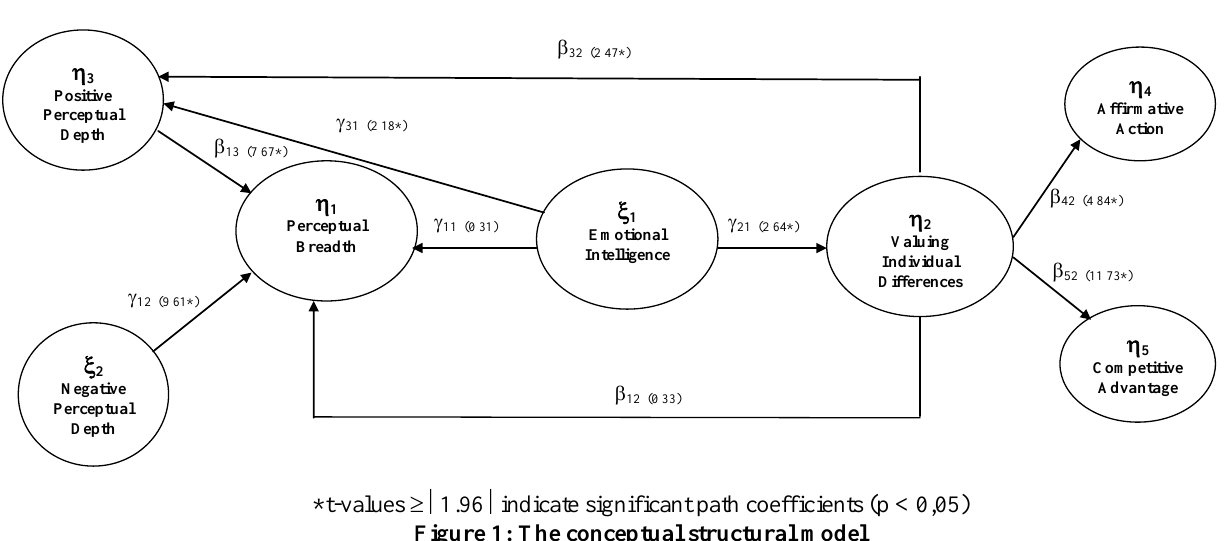
Figure 1: The conceptual structural